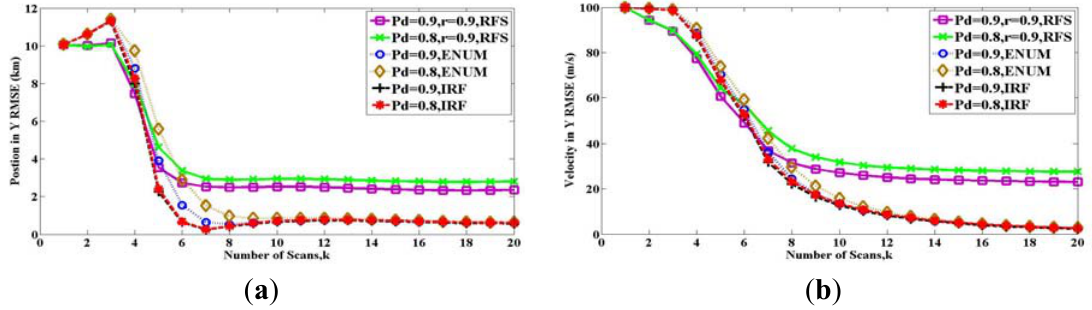
Figure 4. Comparisons of bounds with different detection probability P axes ( b ) Velocity in Y axes.